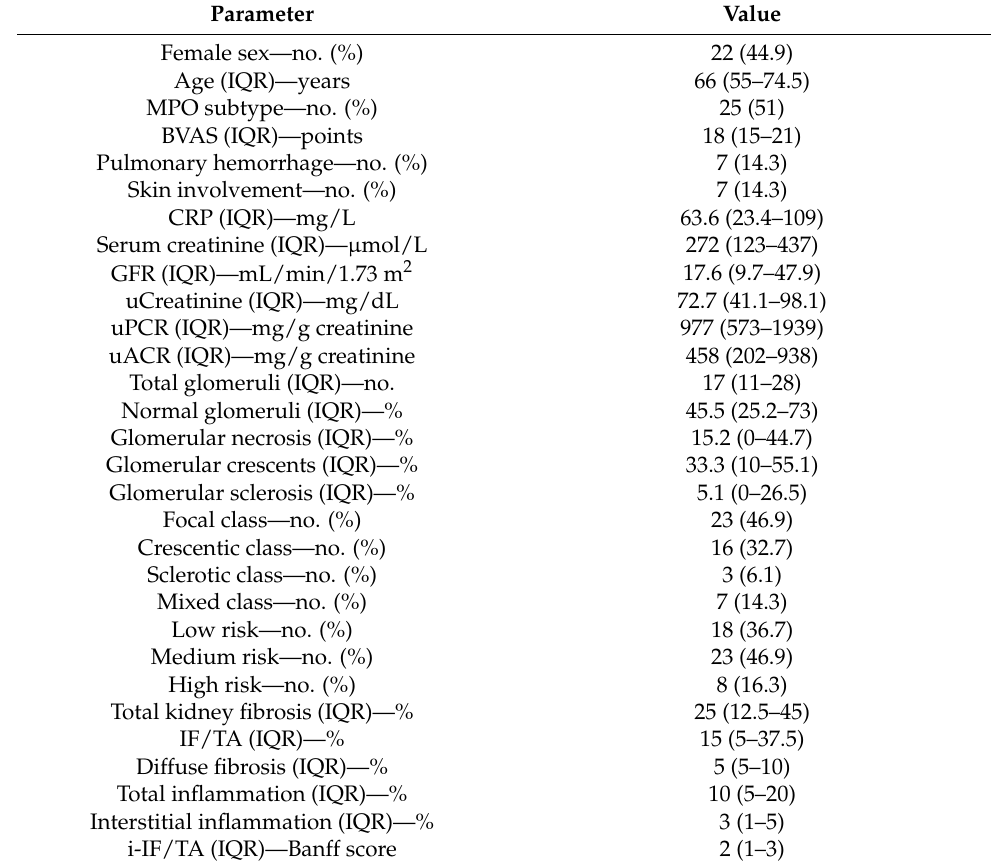
Table 3. Total patient cohort of ANCA